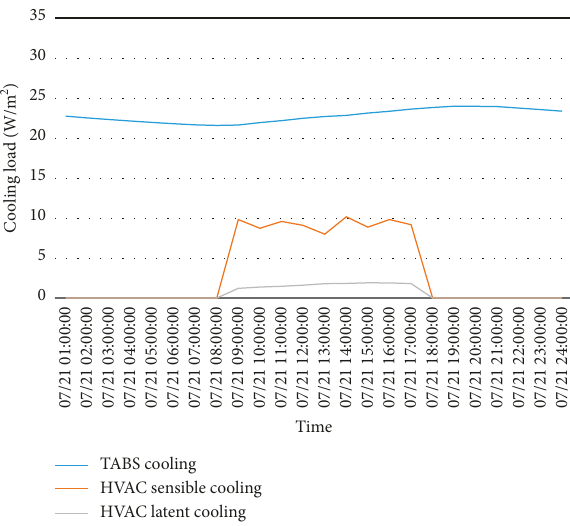
Figure 15: Amount of TABS and CAV systems’ cooling in the lecture room.